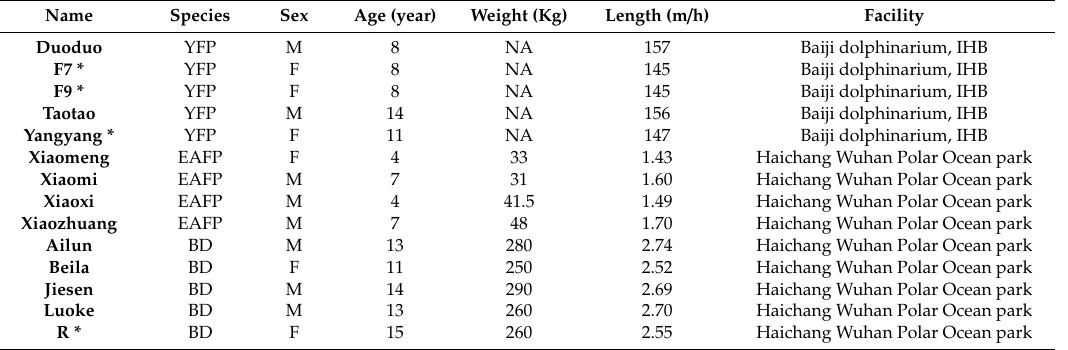
Table 1. Catalogue of studied individuals’ features (YFP: Yangtze finless porpoise, EAFP: East-Asian finless porpoise, BD: bottlenose